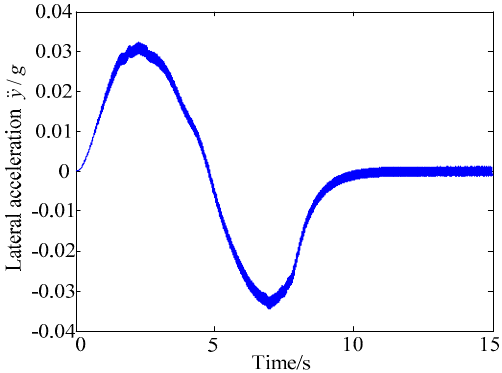
Figure 18. Lateral acceleration of vehicle p .